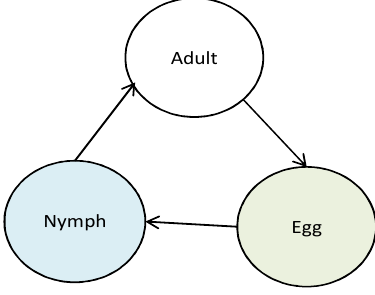
Figure 1. The life cycle of grasshoppers.